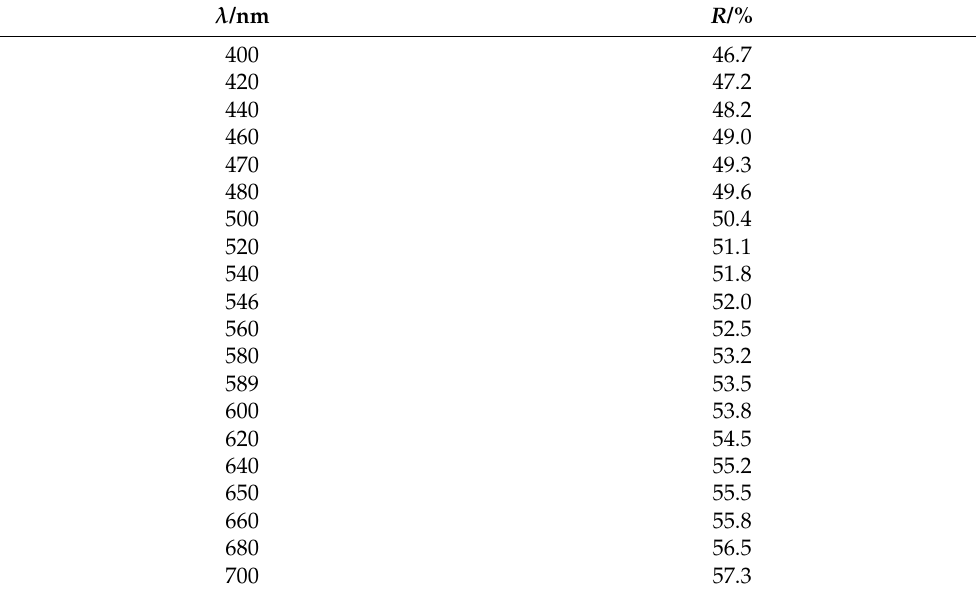
Table 1. Spectral reflectance of siderazot in air. The four wavelengths at 470, 546, 589, and 650 nm are interpolated. Unoriented